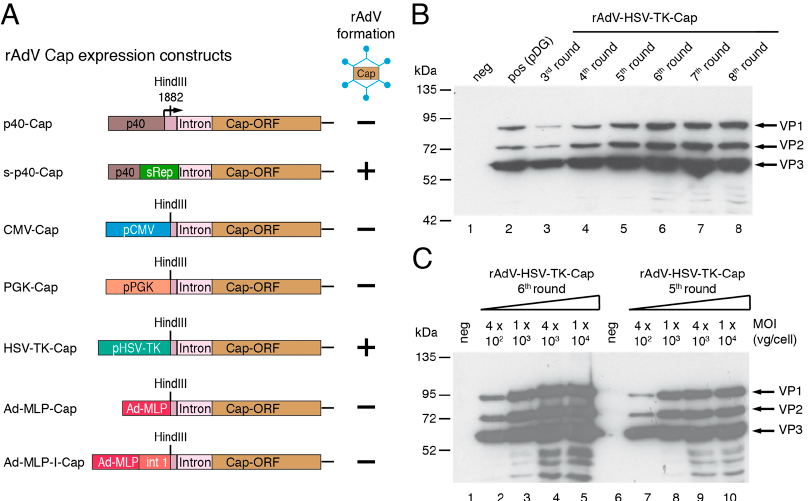
Figure 3. Generation of rAdV for AAV-2 capsid protein expression. ( A ) Schematic presentation of the adenoviral shuttle plasmids. Formation of rAdV after transfection of the corresponding PacI-linearized pAdEasy plasmids into HEK293 cells is indicated by “+“ and “-“ signs. ( B ) Infection of HEK293 cells for 64 h with equal amounts of freeze–thaw supernatants from amplification rounds 3 to 8 of rAdV-HSV-TK-Cap amplification with subsequent anti-Cap western analysis of whole cell extracts. Arrows indicate positions of capsid proteins VP1 to VP3. pDG transfected HEK293 cells were used as positive control. ( C ) As in ( B ) with rAdV-HSV-TK-Cap freeze–thaw supernatants from amplification rounds 6 (left lanes) and 5 (right lanes) at different MOIs for 64 h.